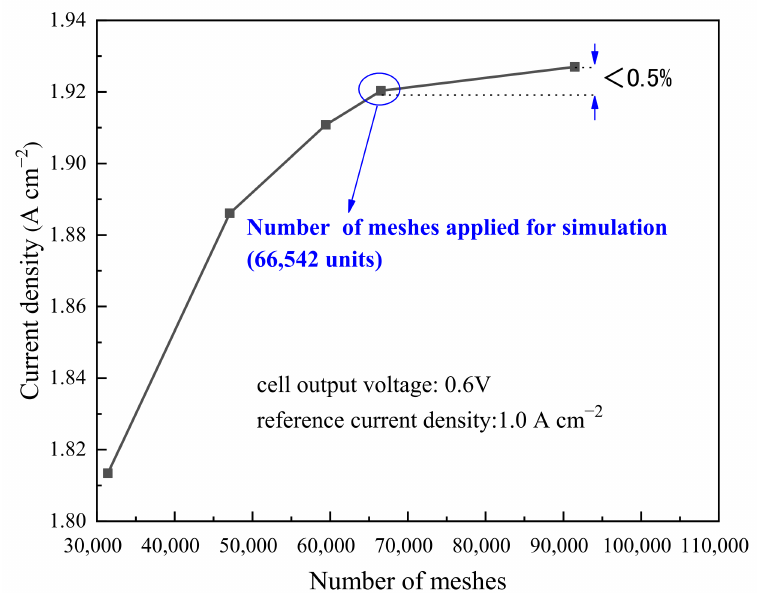
Figure 4. The grid independence testing result.